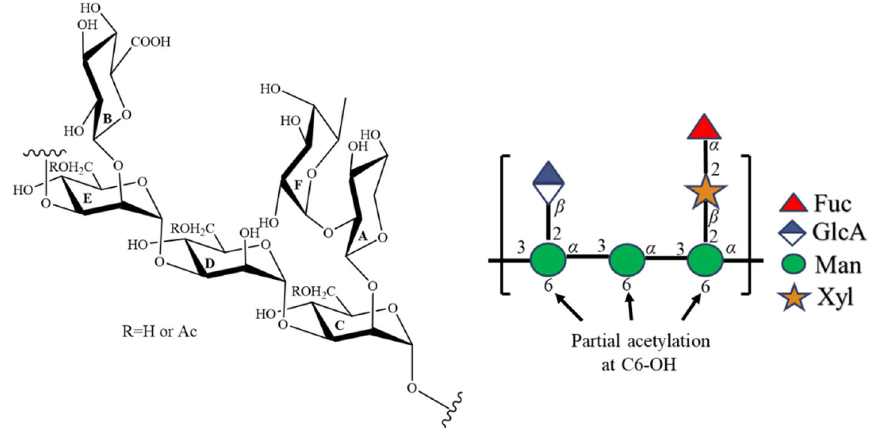
Figure 2. The chemical structure and symbolic nomenclature of TFP ‐ F1